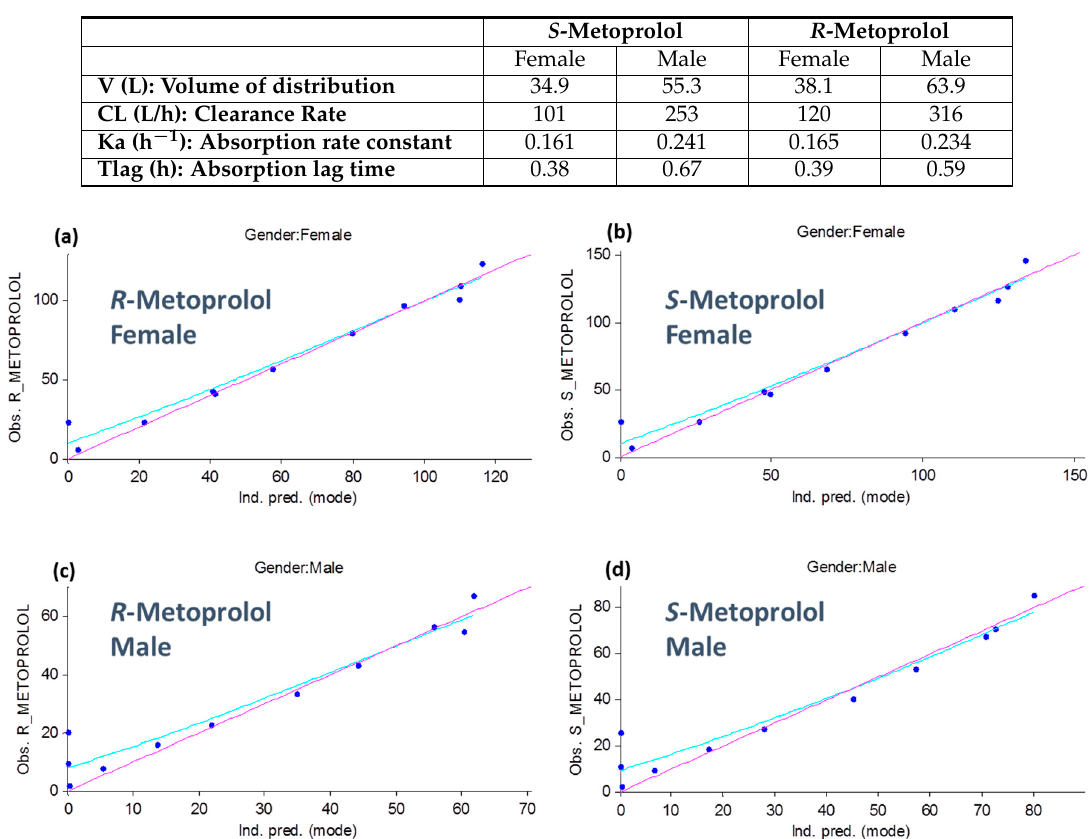
Table 1. One ‐ compartment pharmacokinetic parameters for R ‐ and S ‐ metoprolol for young men and women. Table 1. One-compartment pharmacokinetic parameters for R - and S -metoprolol for young men and women.